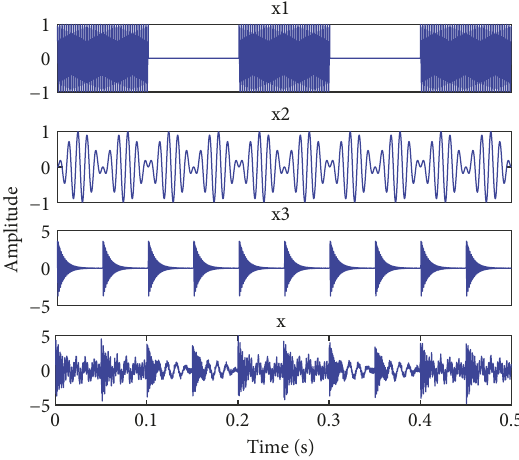
Figure 4: Simulation signal time-domain waveform.